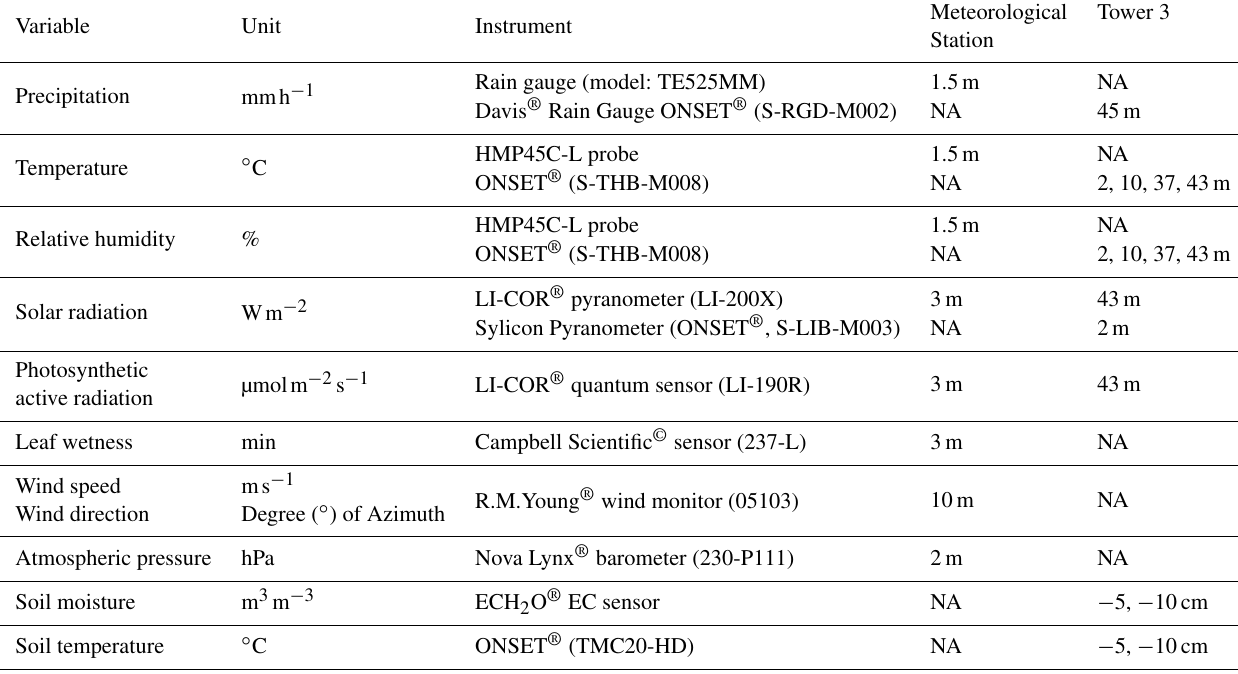
Table B1. Measurement height of the instrumentation used during the experiment carried out in La Selva Biological